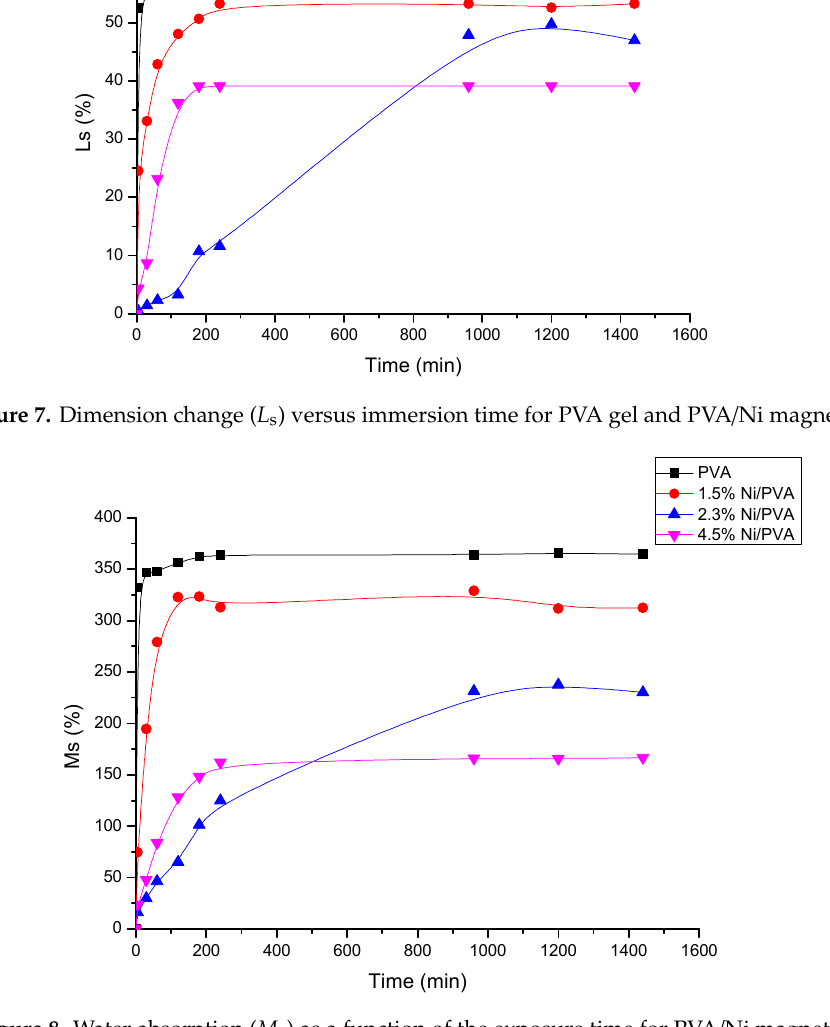
Figure 8. Water absorption ( M s ) as a function of the exposure time for PVA/Ni magnetic gel.